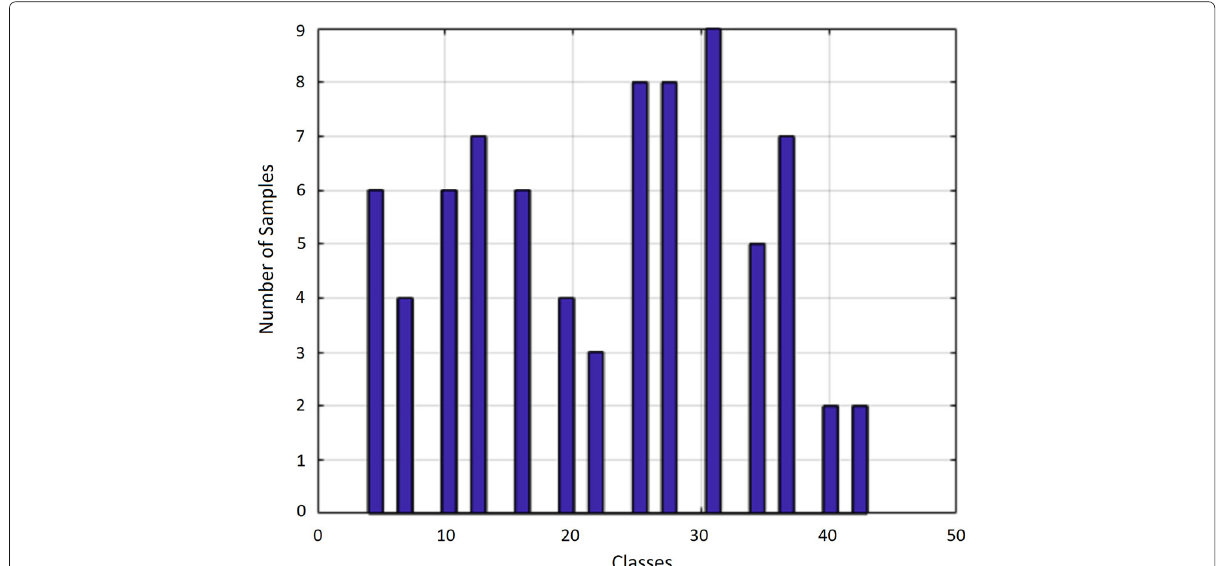
Fig. 3 Number of samples for each class after the clustering algorithm is applied. Turkish database is